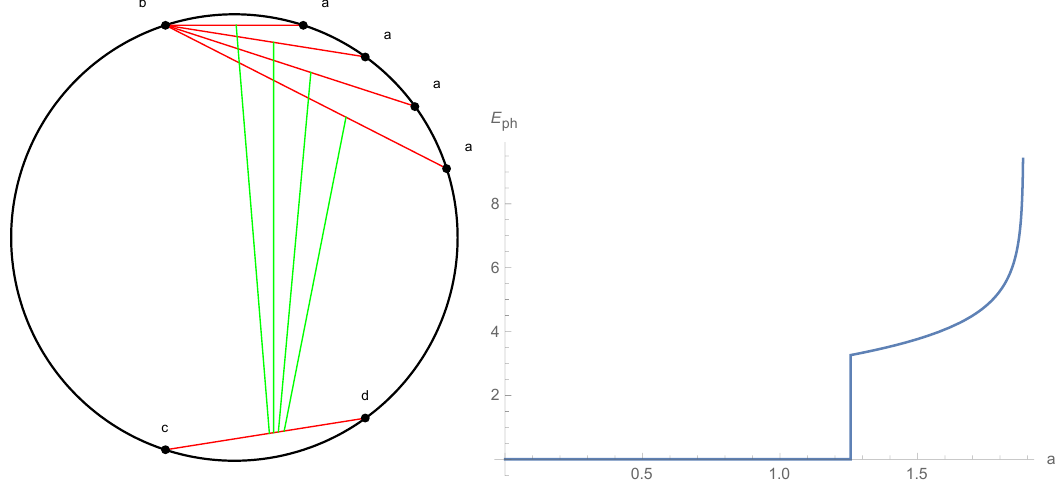
Figure 3. Left: we vary the position of a and keep b , c , d (cid:12)xed. The values chosen here are b = 0 : 6 (cid:25) , c = 1 : 4 (cid:25) and d = 1 : 7 (cid:25) . The green geodesics are the shortest curves connecting ( ab ) to ( cd ). Here we use the Beltrami-Klein coordinate system (explained in appendix B), in which geodesics are straight lines. Right: plot of the E ph as a function of a , over the range a E ph diverges when a = b , and undergoes a phase transition near a changes topology). We set 4 G N =